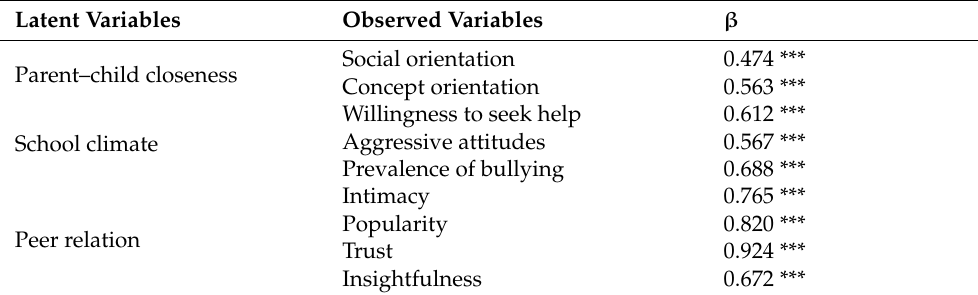
Table 3. Results of measurement model.